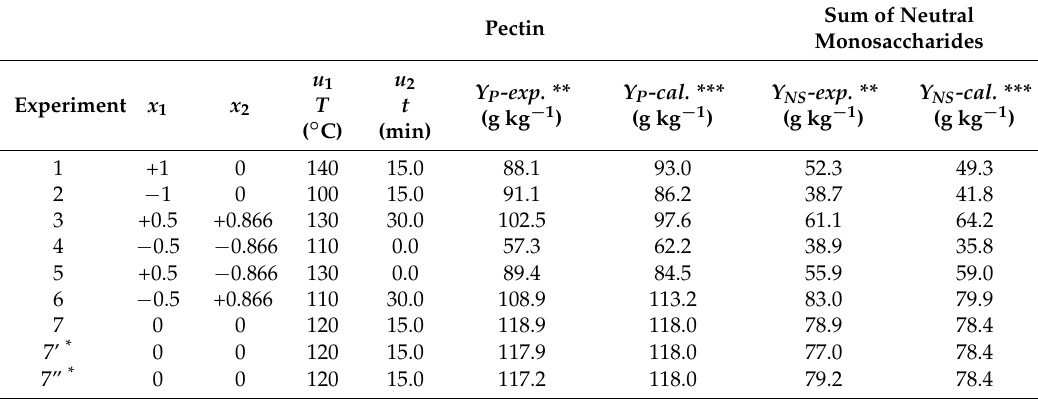
Sum of Neutral Pectin Monosaccharides